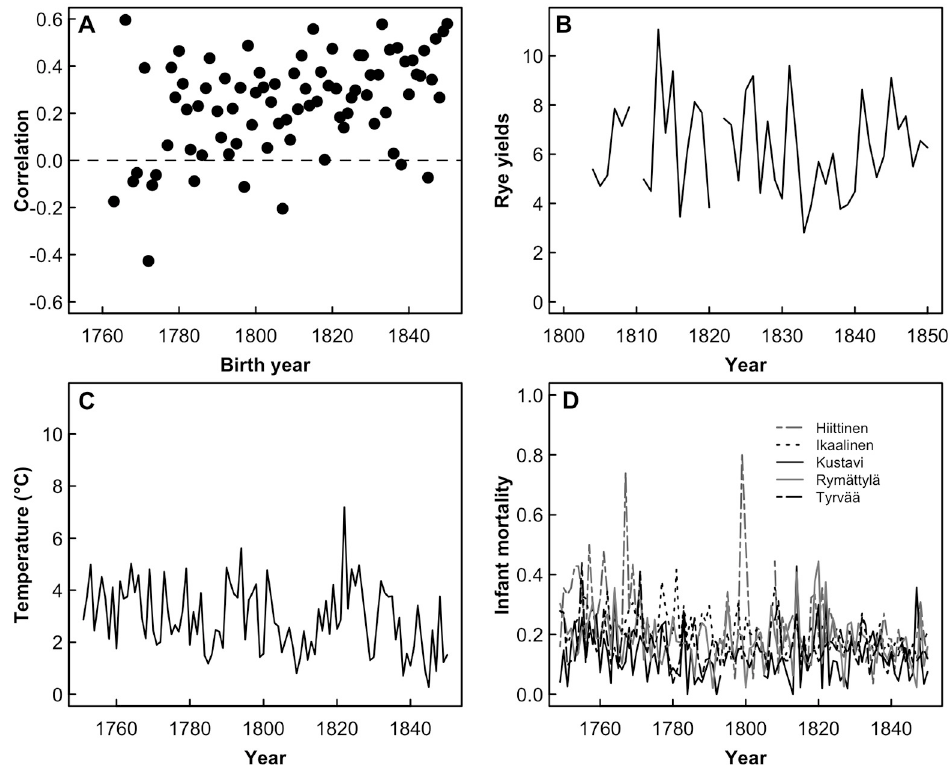
Fig 1. Variation in the relationship between children born and lifespan, and environmental conditions in the study period (1751–1850); (a) the relationship between number of children born and post-reproductive lifespan among 81 birth cohorts (1751–1850) varied between r s = -0.43 and r s = 0.6, but is on average positive, indicating higher reproduction is associated with longer lifespan; (b) rye yields varied between years across the study period; (c) spring temperature estimated using multiproxy reconstruction varied substantially between years during the studied period; (d) the proportion of children who were born in a given year and died before the age of 1 (infant mortality) varied between years in the five studied parishes between 0.0 and